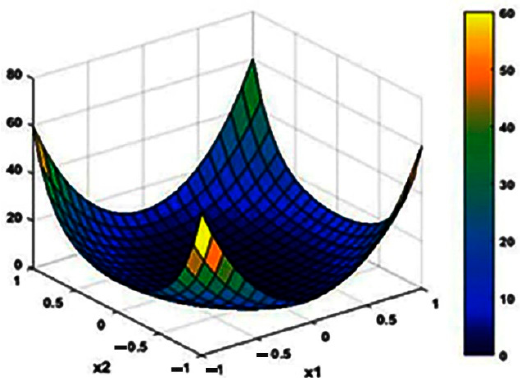
Figure 4. Surface h ( x ) for large range of x 1 ( t ), x 2 ( t ) and check the condition h ( x ) > 0 for stability of nonlinear system (34).